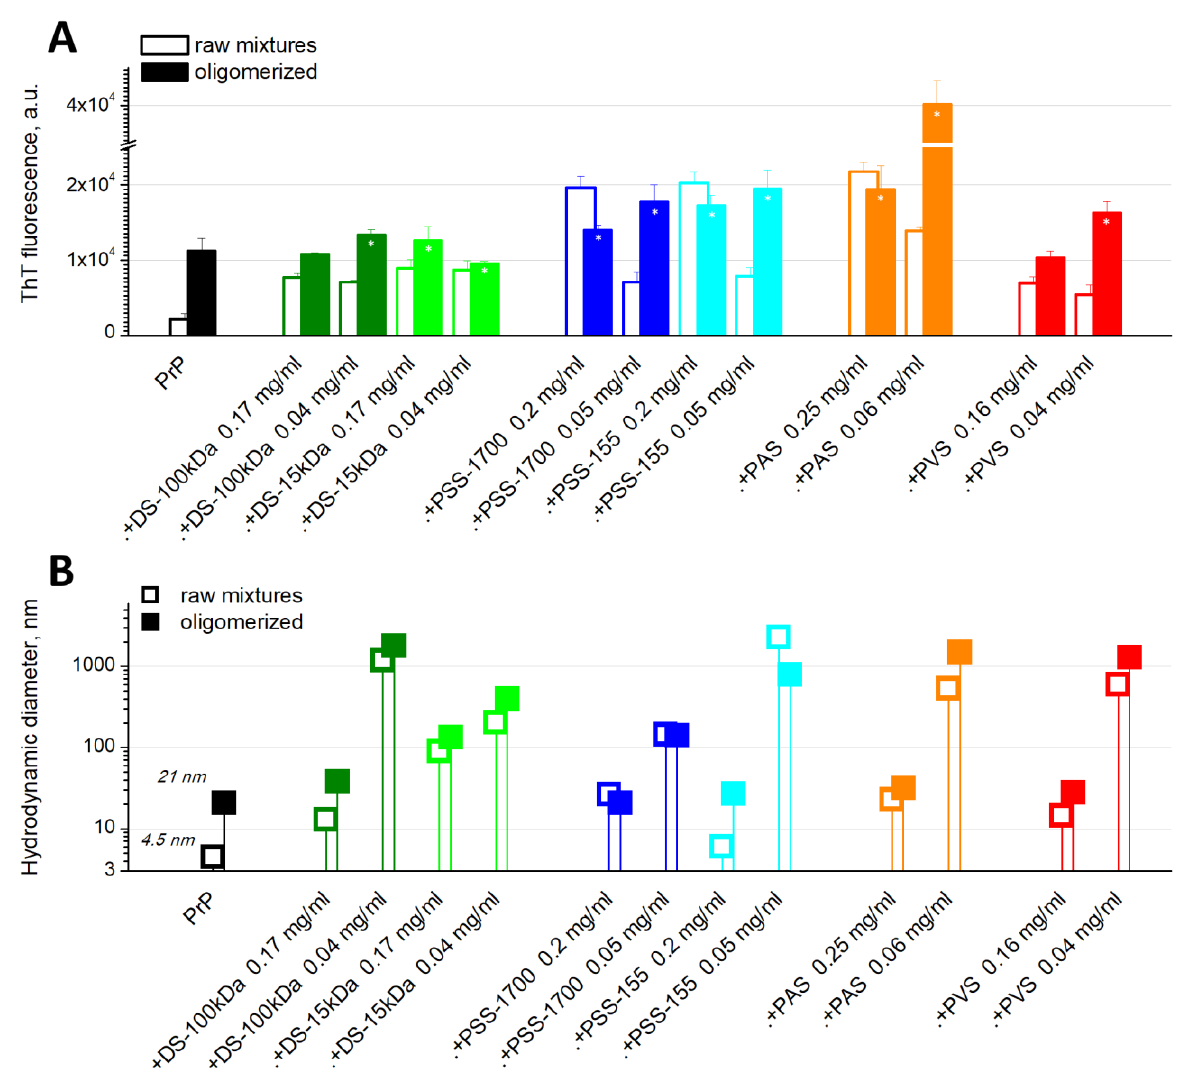
Figure 1. ThT fluorescence intensity (( A ) mean ± SD, asterisks “*” mark statistically significant difference from PrP oligomers) and hydrodynamic diameter of particles ( B ) in the solution of free PrP (black bar/squares) and mixtures of PrP and the polyanions (colored bars/squares) mixed at room temperature (empty bars/squares) and after an oligomerization-inducing treatment (i.e., 1 h incubation at 65 ◦ C) (filled